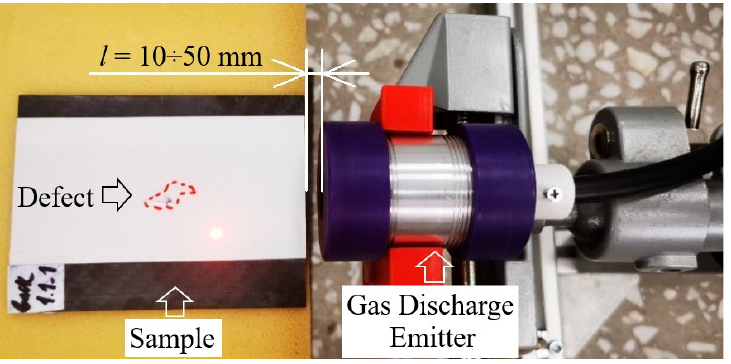
Figure 9. Acoustic stimulation of CFRP composite with 15 J impact damage by using air-coupled gas discharge device.